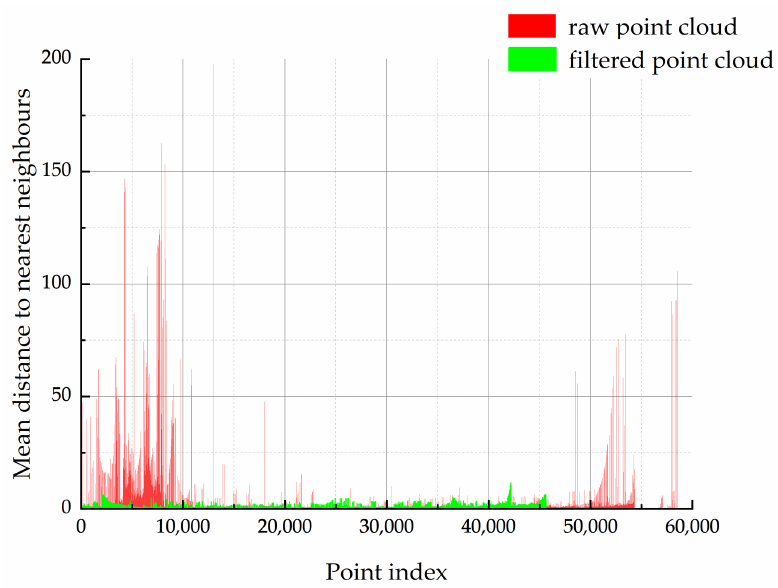
Figure 12. Mean distances to nearest neighbors of